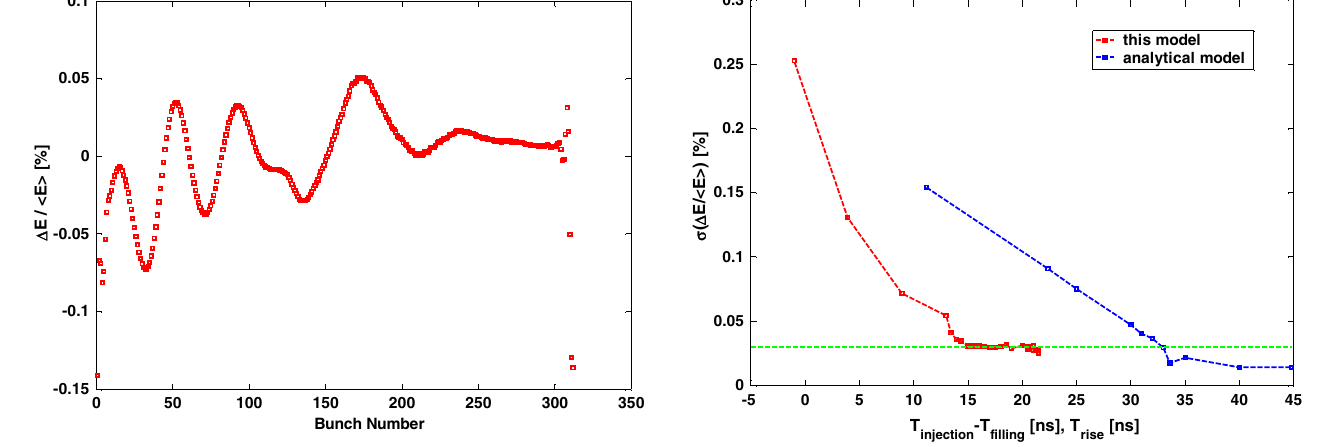
(cid:1) injection